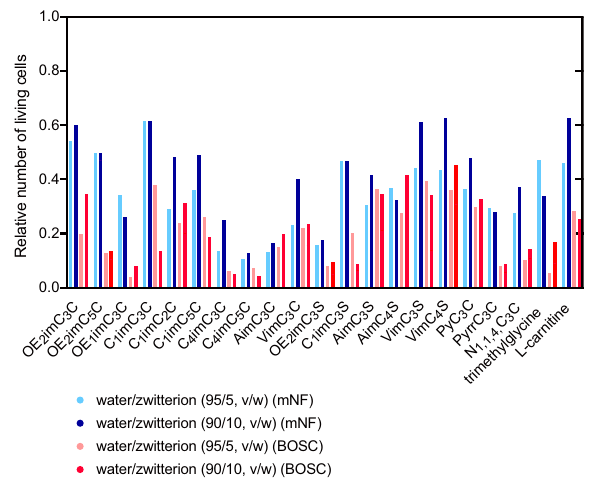
Fig. 4 Relative number of living mNF and BOSC cells after cryopreservation using water/zwitterion (95/5 and 90/10, v/w). ( n = 3, experimentally triplicate) The actual data points are shown in Fig.